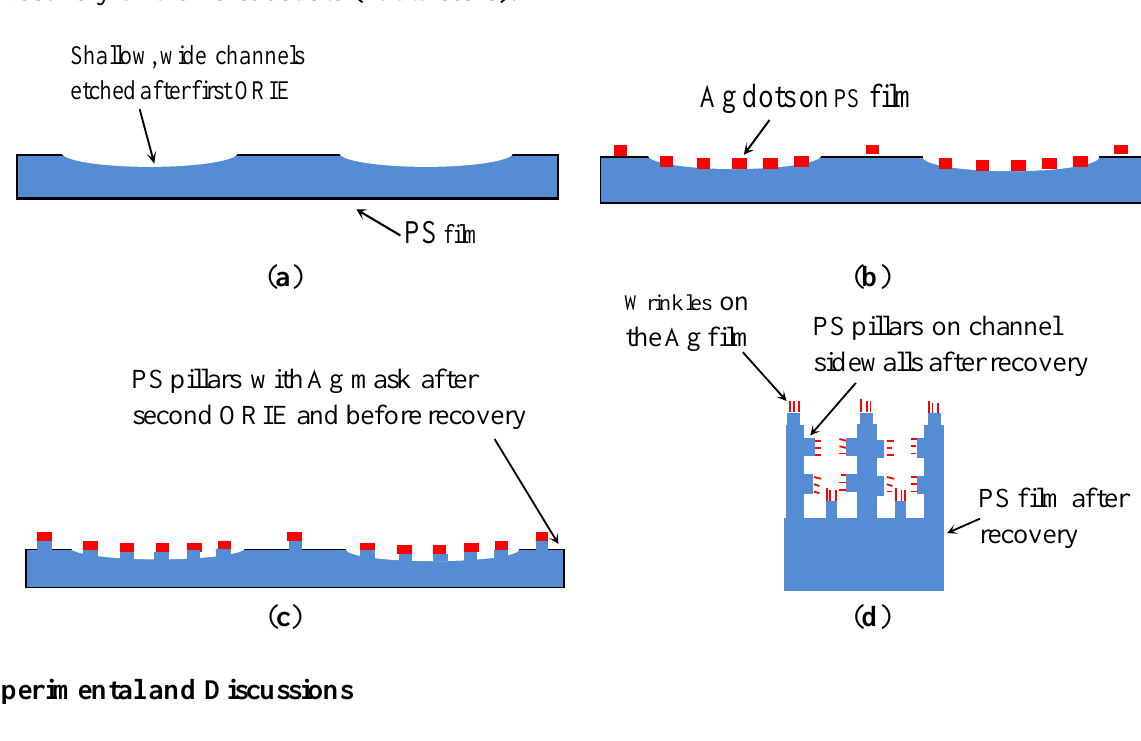
Figure 1. Schematics of the four-step procedure used to fabricate super-hydrophobic microchannels. ( a ) Generate shallow, wide channels; ( b ) Create Ag microdots on the substrate; ( c ) Produce micropillars; and ( d ) Complete the fabrication through strain recovery of the PS substrate (not to